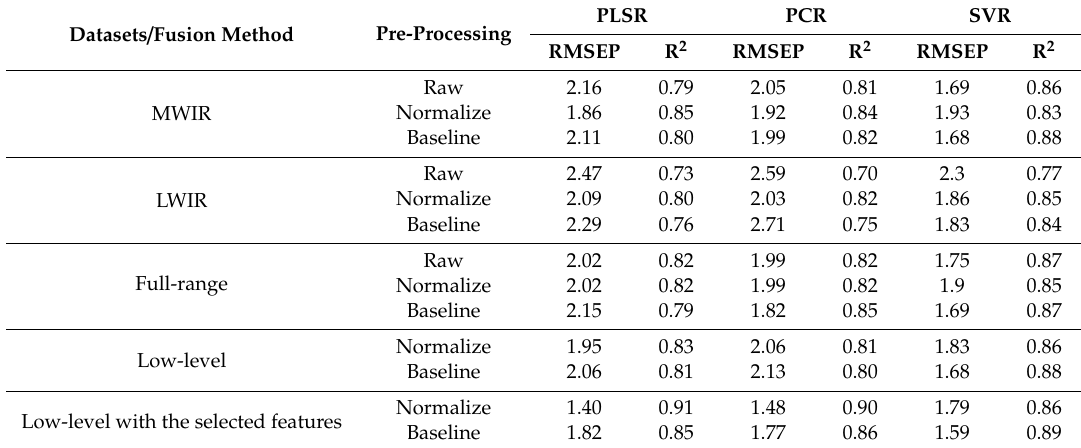
Table 3. Statistical summary of the PLSR, PCR, and SVR models for the prediction of Al 2 O 3 . The concentrations of Al 2 O 3 in the analysed samples were in the range of 0.06 − 15.9